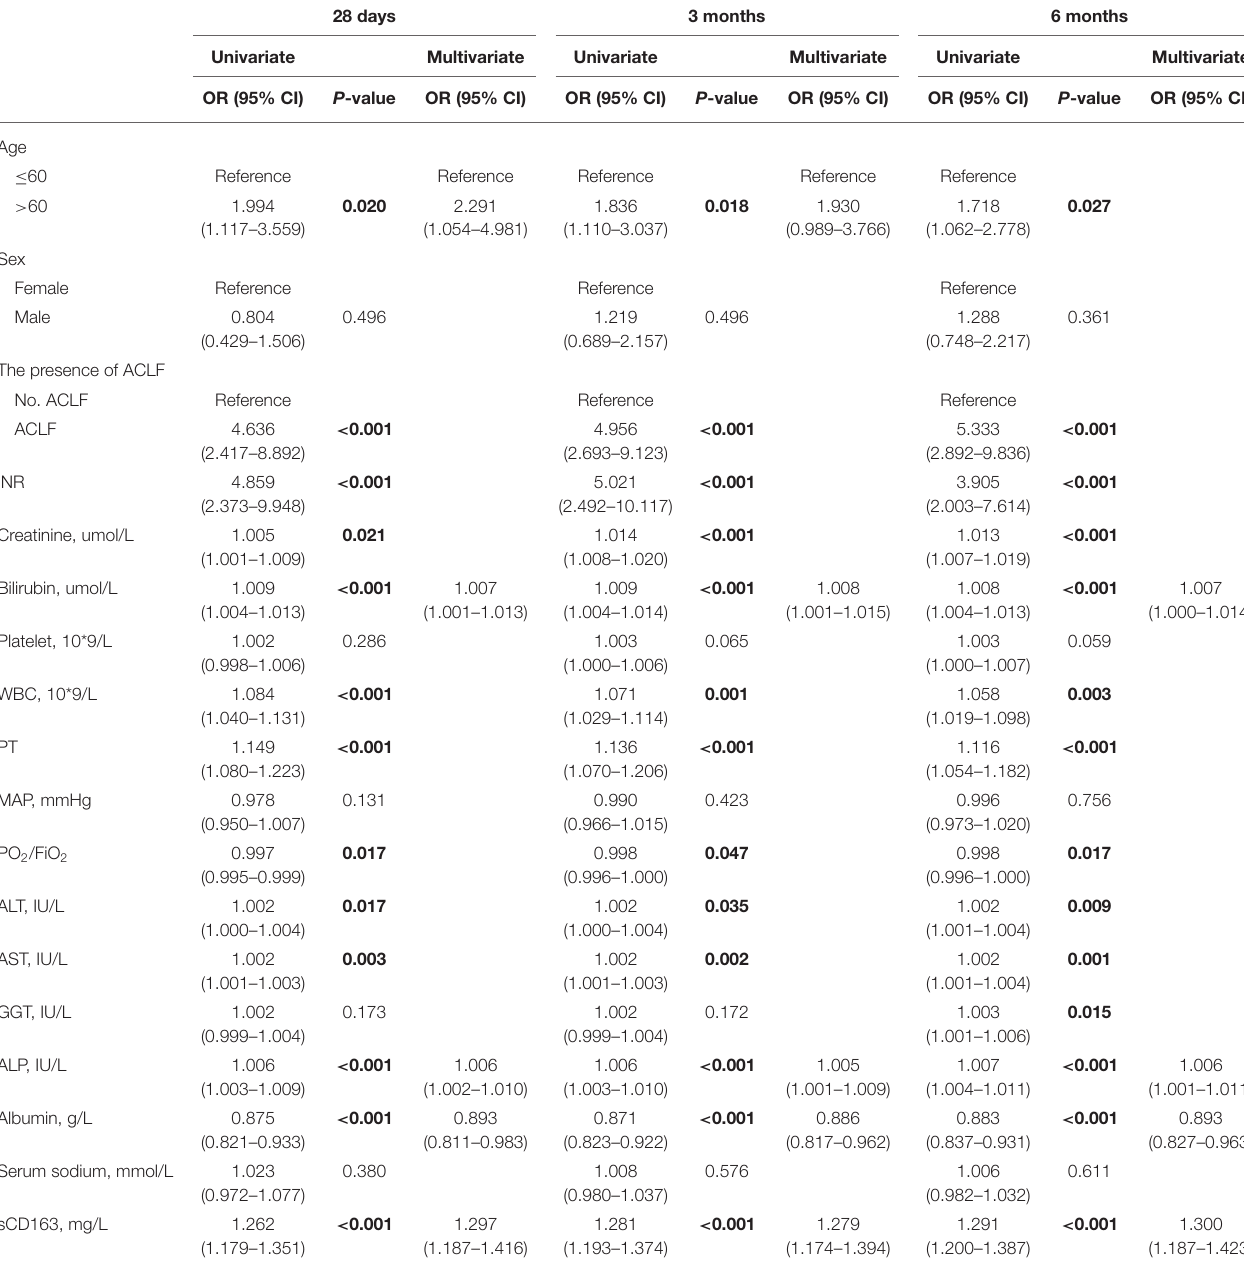
TABLE 4 | Independent predictors for 28-day, 3-month and 6-month mortality in univariate and multivariate